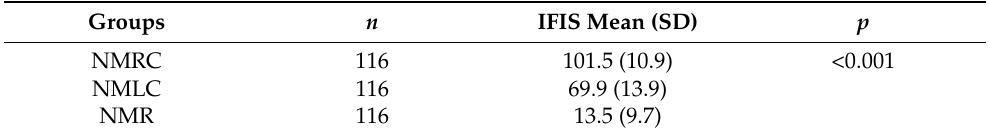
Table 1. Semiquantitative myeloperoxidase protein expression in normal colorectal mucosa of patients undergoing colonoscopy, by immunofluorescence and confocal microscopy analyses (IFIS score). NMRC, normal mucosa of the right colon; NMLC, normal mucosa of the left colon; NMR, normal mucosa of the rectum.